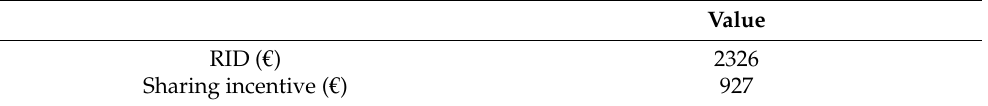
Table 5. Economic inflows derived from the RID and the incentive for the shared energy. Value RID ( € ) 2326 Sharing incentive ( € ) 927